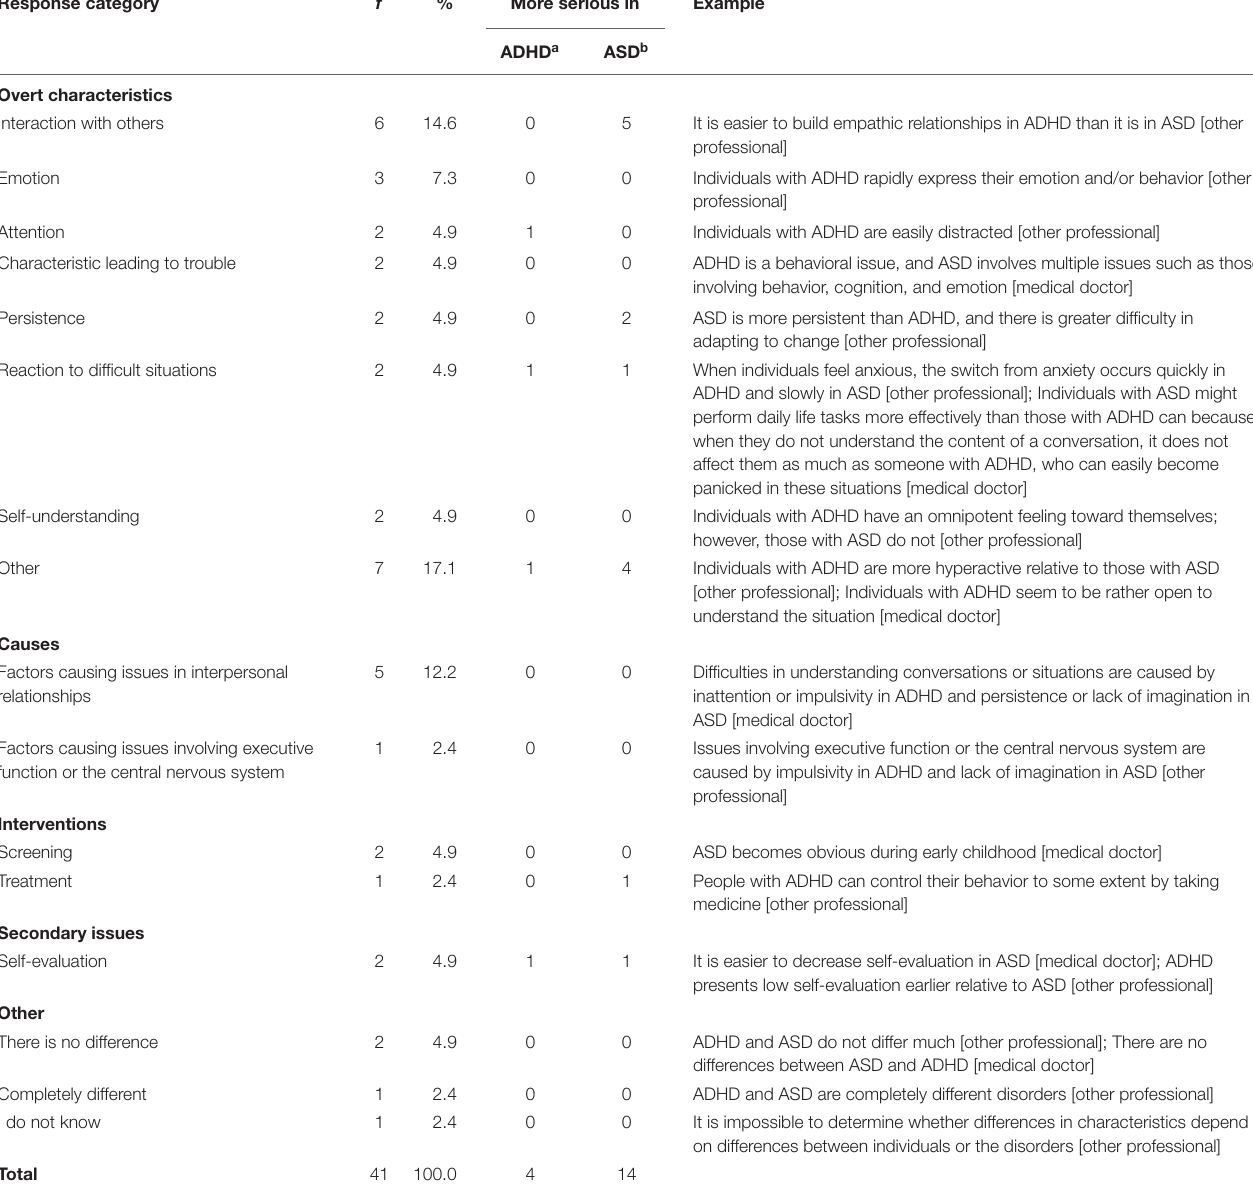
TABLE 3 | Psychological differences between ADHD and ASD ( N =